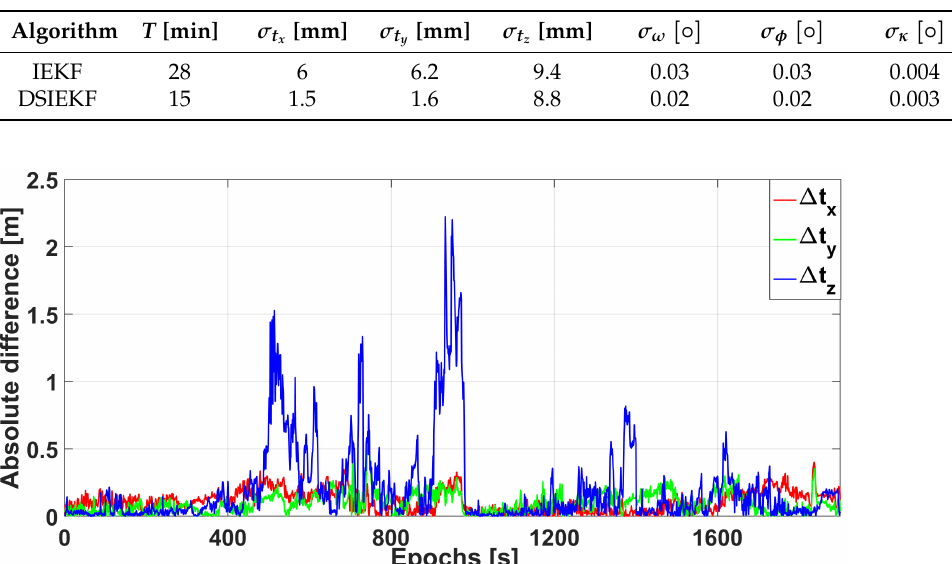
Table 3. Measures of different variables over 1902 epochs for each algorithm. T : Duration of the update step, σ : Mean standard deviation of the state parameters.